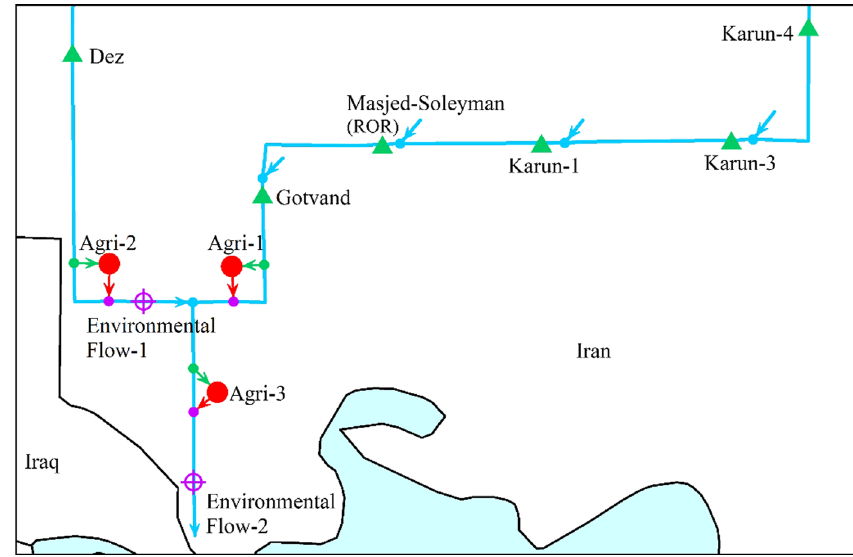
Fig. 2 Schematic view of reservoirs and demands sites in WEAP model